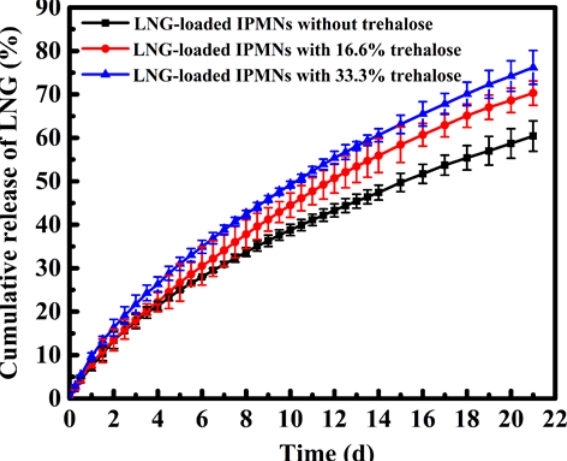
Figure 7. In vitro cumulative LNG release profiles from LNG-loaded IPMNs with different contents of trehalose at 37 °C (mean ± s.d., n = 3). PLGA arrowhead formulas of IPMNs all used the matrix with PLGA:LNG at a 3:2 mass ratio. LNG-loaded IPMNs without trehalose ( ■ ), with 16.6% trehalose (●) and with 33.3% trehalose ( ▲ ). The amount of LNG in one piece of IPMNs was 50 μg. Release medium was 40% polyethylene glycol 400-PBS, pH = 7.4.